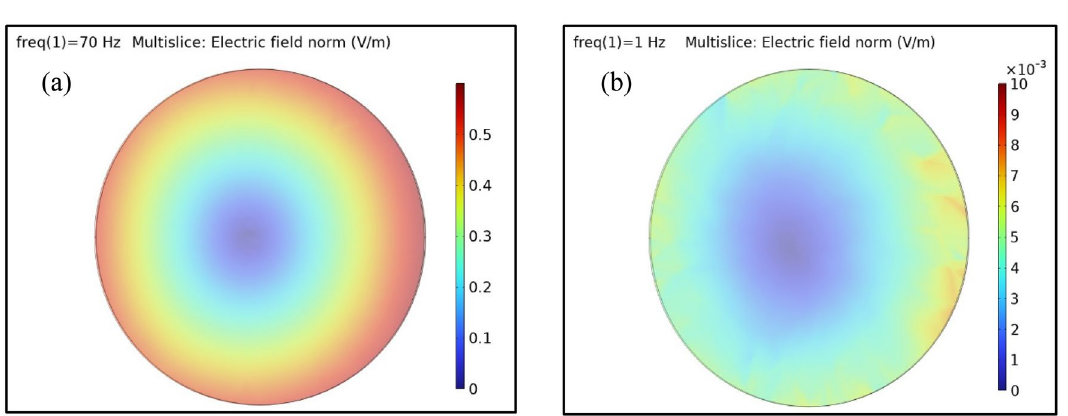
Figure 5. Simulation of the induced electric field for a 35 mm Petri dish using COMSOL software. Plot showing ( a ) the induced electric field for 70 Hz and 150 mT, ( b ) the induced electric field for 1 Hz and 100